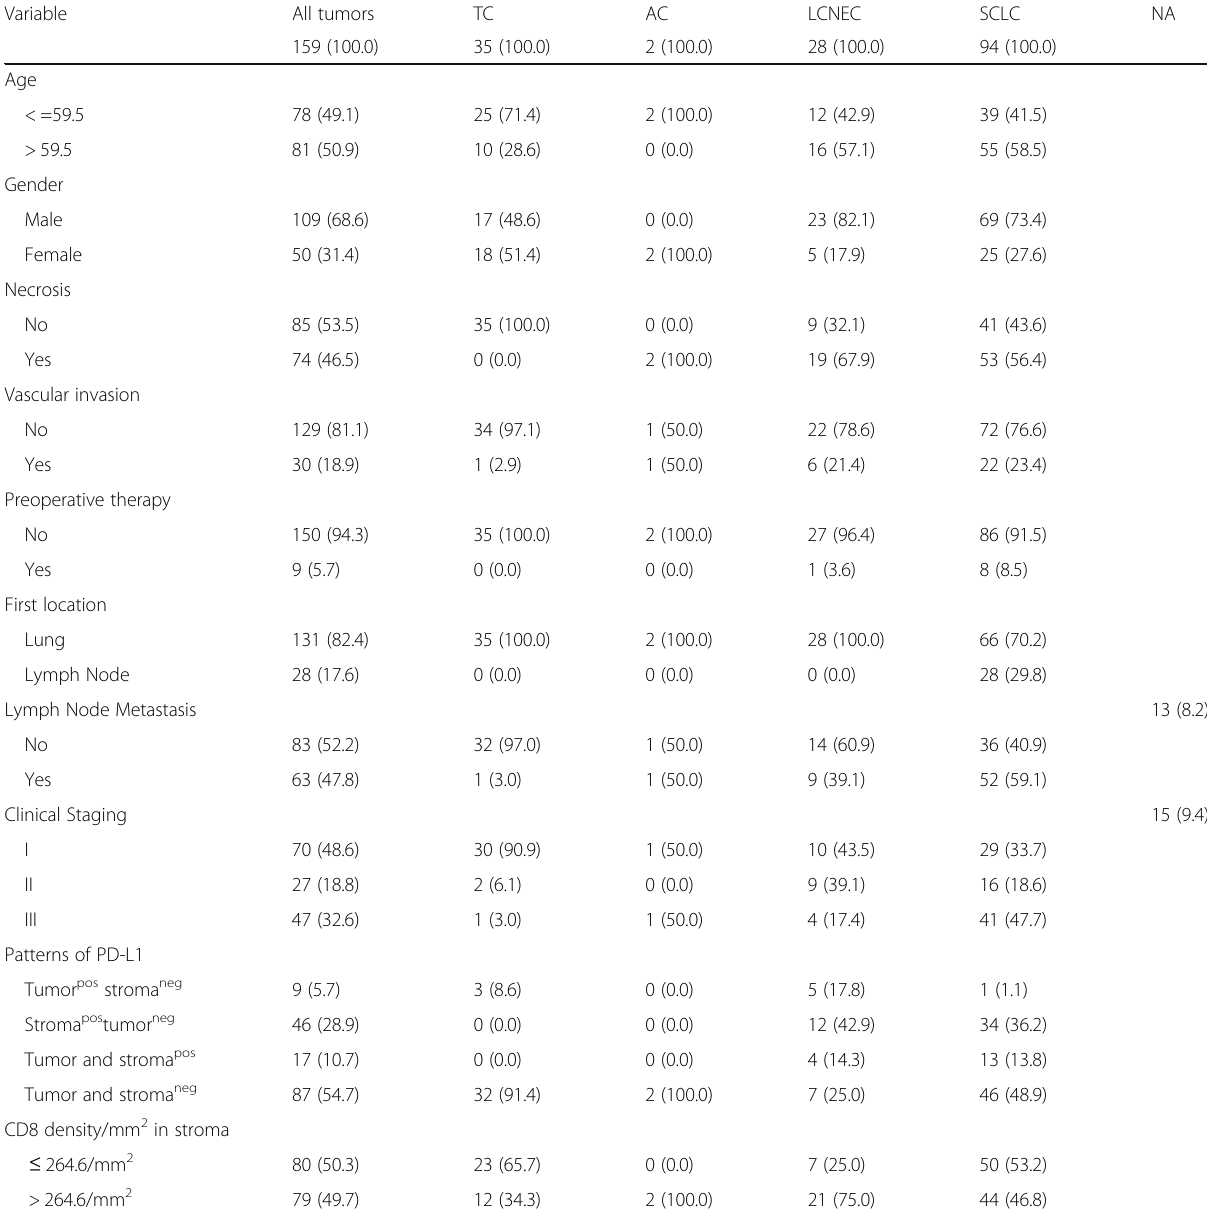
Table 1 Clinical characteristics in the four